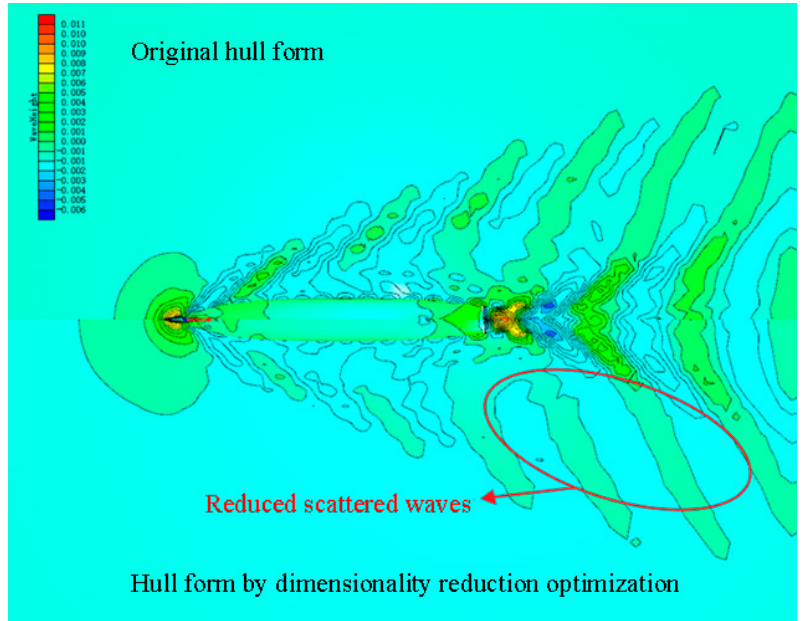
Figure 26. Comparison of wave disturbances of original hull form and hull form obtained by dimensionality reduction optimization.